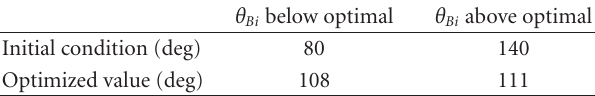
Table 4: Table of optimized magnetic field angle for stationary ionized zone.